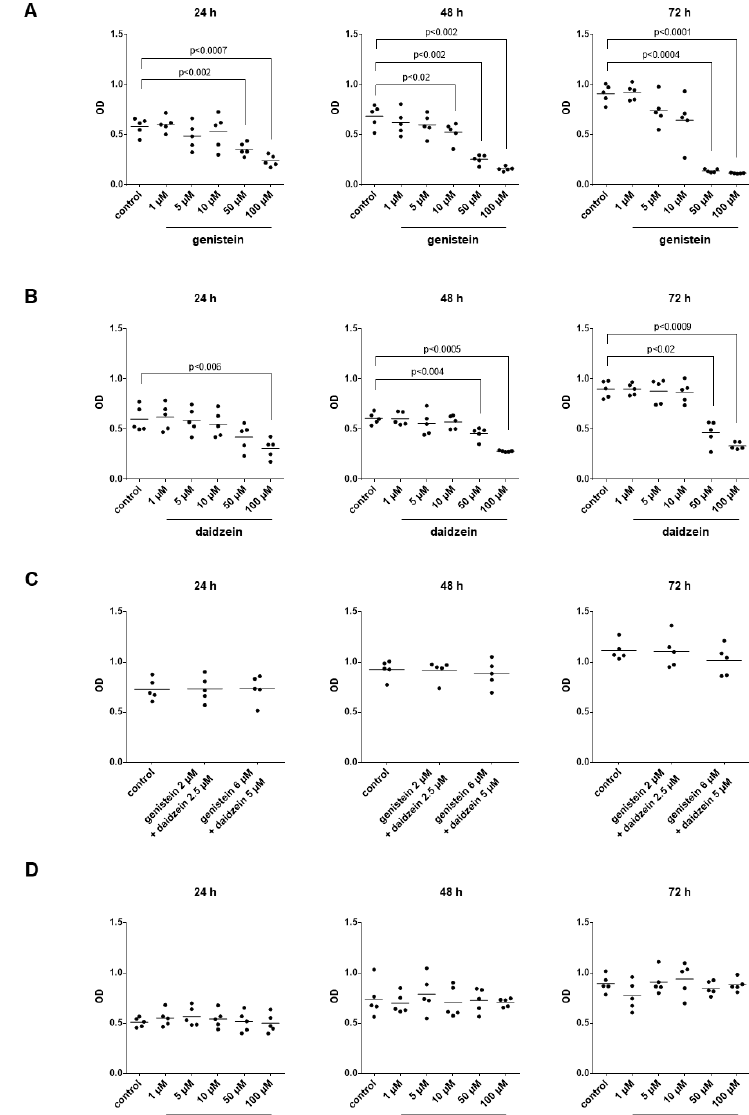
Figure 10. Effects of genistein, daidzein and puerarin on the viability of WPMY-1 cells. Viability was assessed by CCK-8 assays, following culture with genistein ( A ), daidzein ( B ), combinations of genistein with daidzein ( C ) and puerarin ( D ) at the indicated concentrations or solvent (DMSO for genistein and daidzein, methanol for puerarin) for the controls and for indicated periods. Shown are all single values together with means from quantification of five independent experiments and representative experiments for each series, along with p -values from one-way ANOVA with Dunnett’s tests.